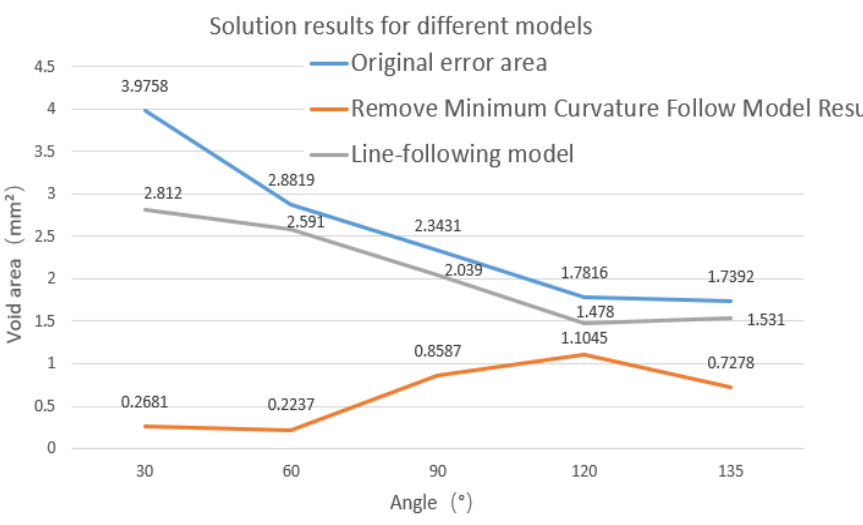
Figure 22. Simulation parameters at different angles.